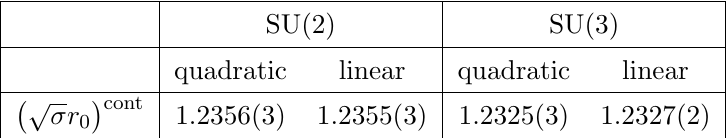
Table 4 . Results from the continuum extrapolations with b (cid:27) = 0 (linear) and b (cid:27)